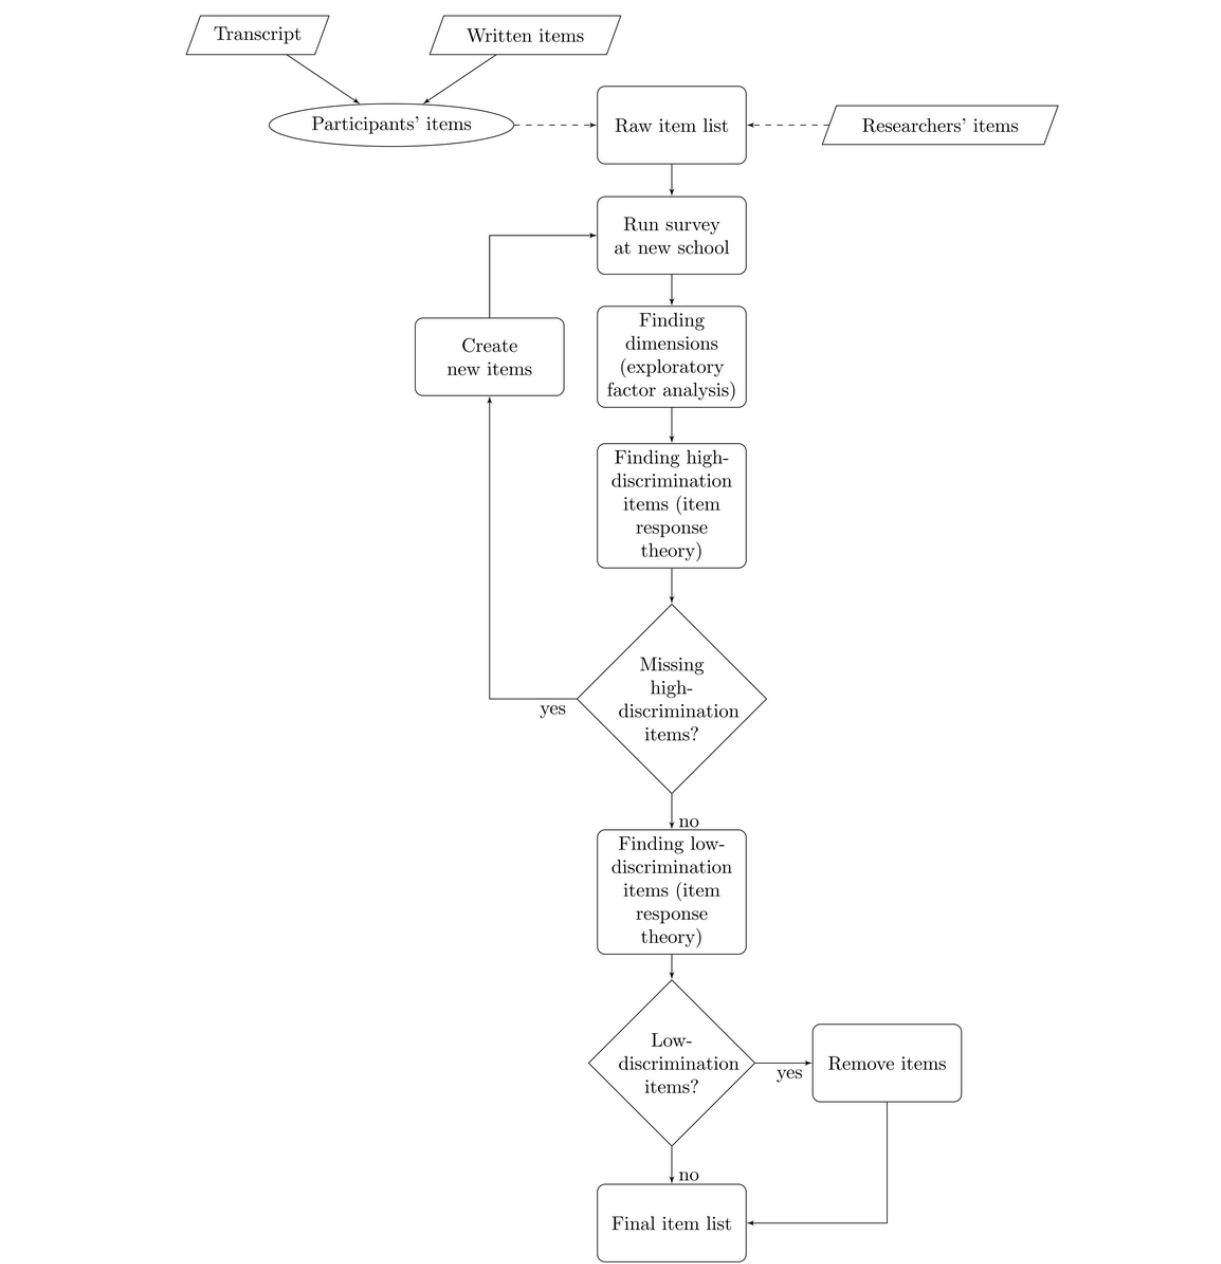
Figure 3. Model validation